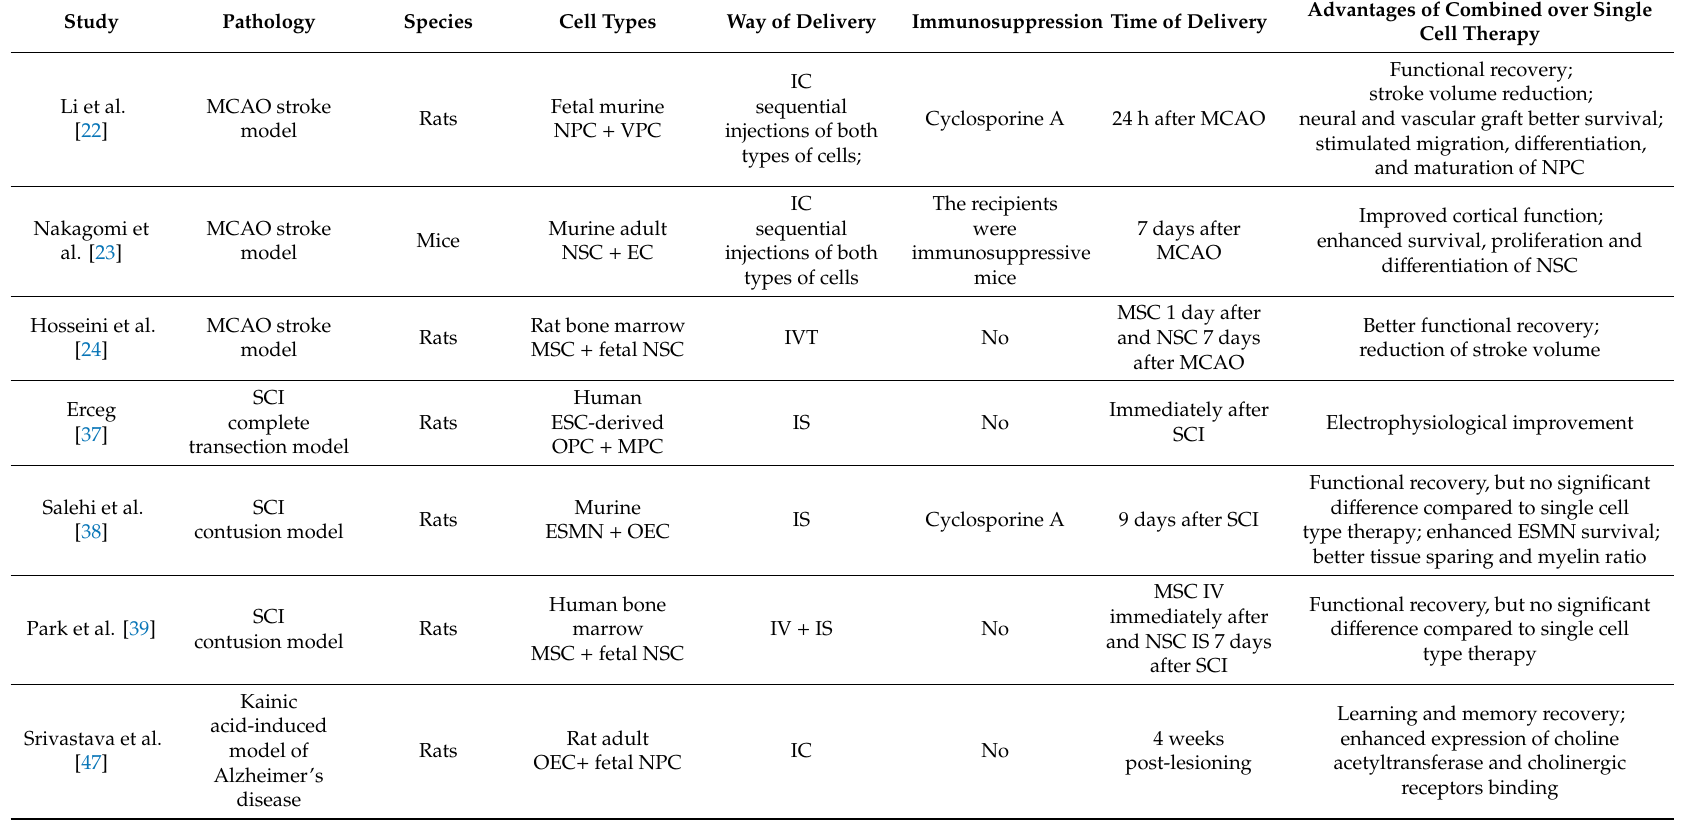
Table 1. Summary of the results of combined cell therapy in animal studies. EC—endothelial cells; ESC—embryonic stem cells; ESMN—embryonic stem